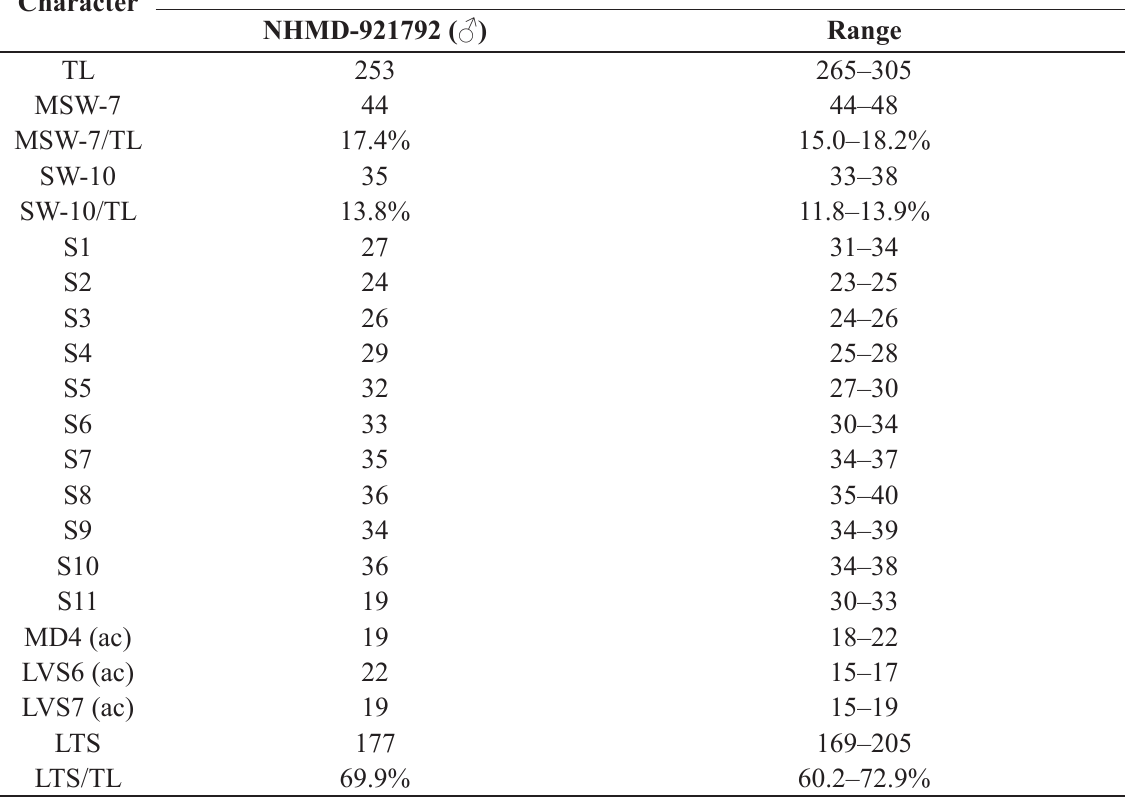
Table 26. Measurements from light microscopy of Echinoderes sp. aff. E. unispinosus (in µm) from the Hikurangi Margin with comparison of measurements for E. unispinosus Yamasaki et al ., 2018 from its type